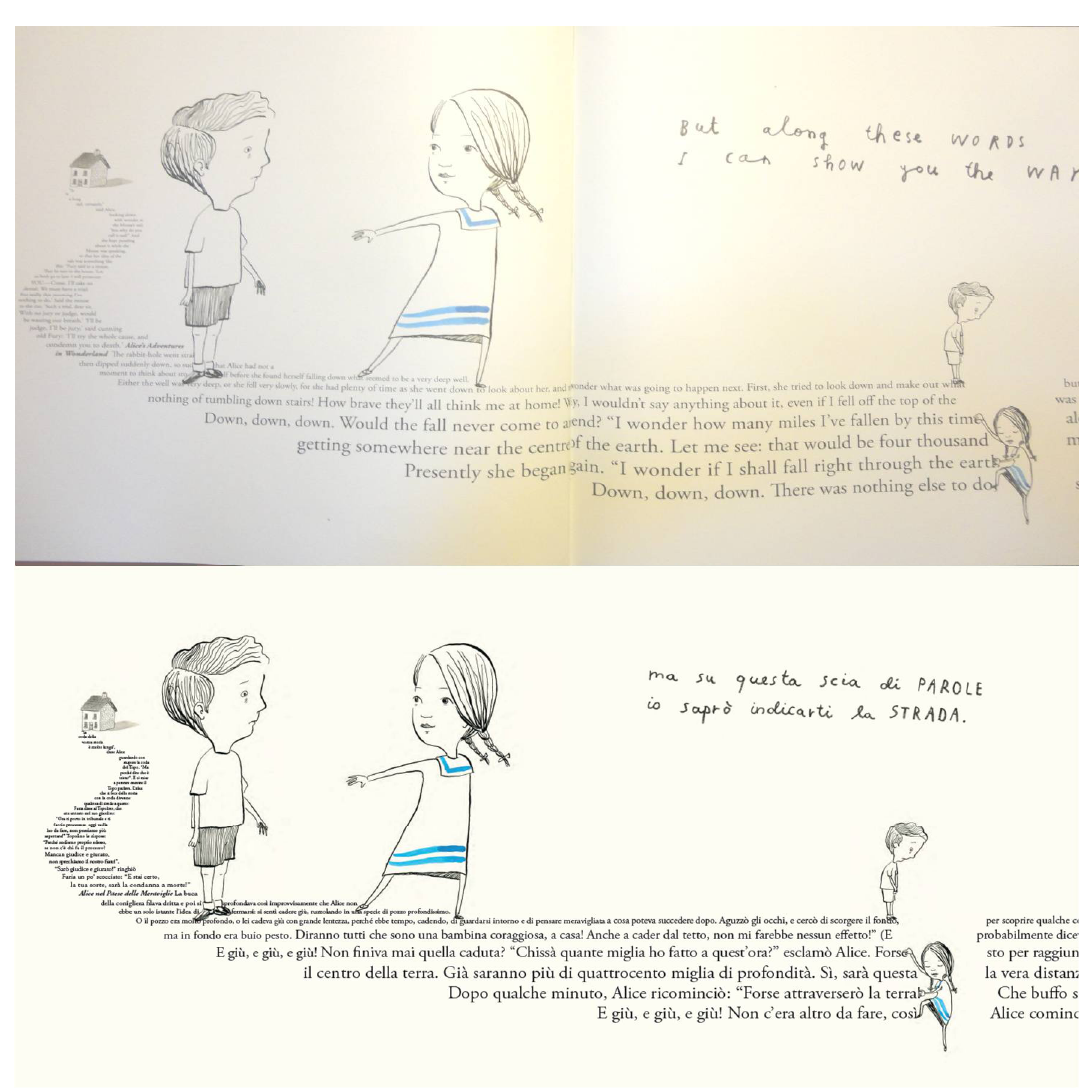
Figure A15. Jeffers O.; Winston S. A child of books, Walker Books, London, 2016; Jeffers O.; Winston S. La bambina dei libri, Lapis, Roma,